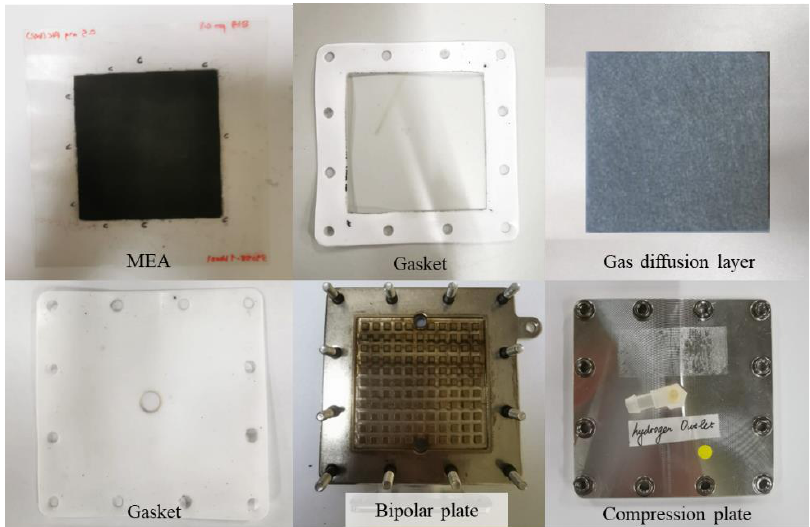
Figure 1. Components of a single-cell stack electrolyzer. A single-cell stack was connected to the peristaltic pump, hydrogen flowmeter, and power supply. Figure 2a,b show the schematic diagram and actual photo of the experimen- tal setup in this study,